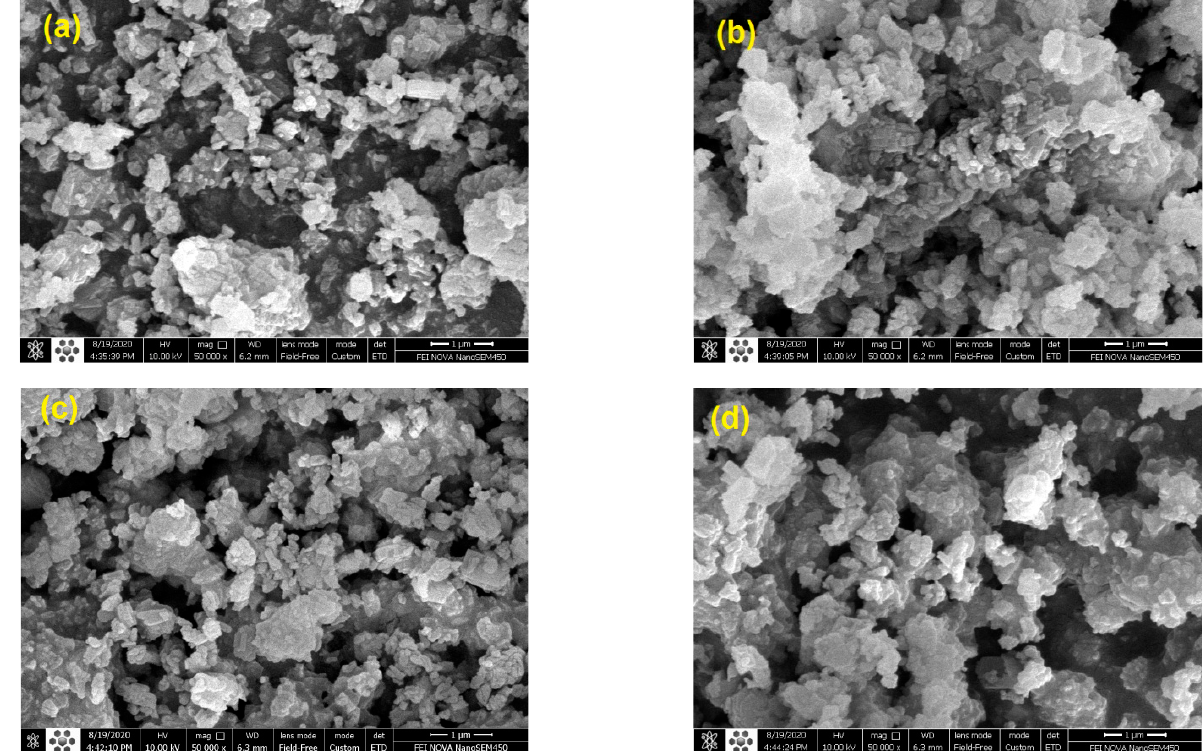
Figure 8. SEM images of HZSM-5 ( a ), 5%La/HZSM-5 ( b ), 10%La/HZSM-5 ( c ), and 15%La/HZSM-5 ( d ).